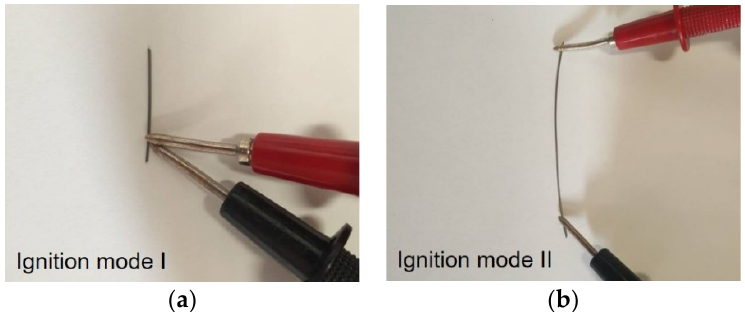
Figure 2. Ignition of the Ni/Me coated wires by ( a ) mode I, and ( b ) mode II.